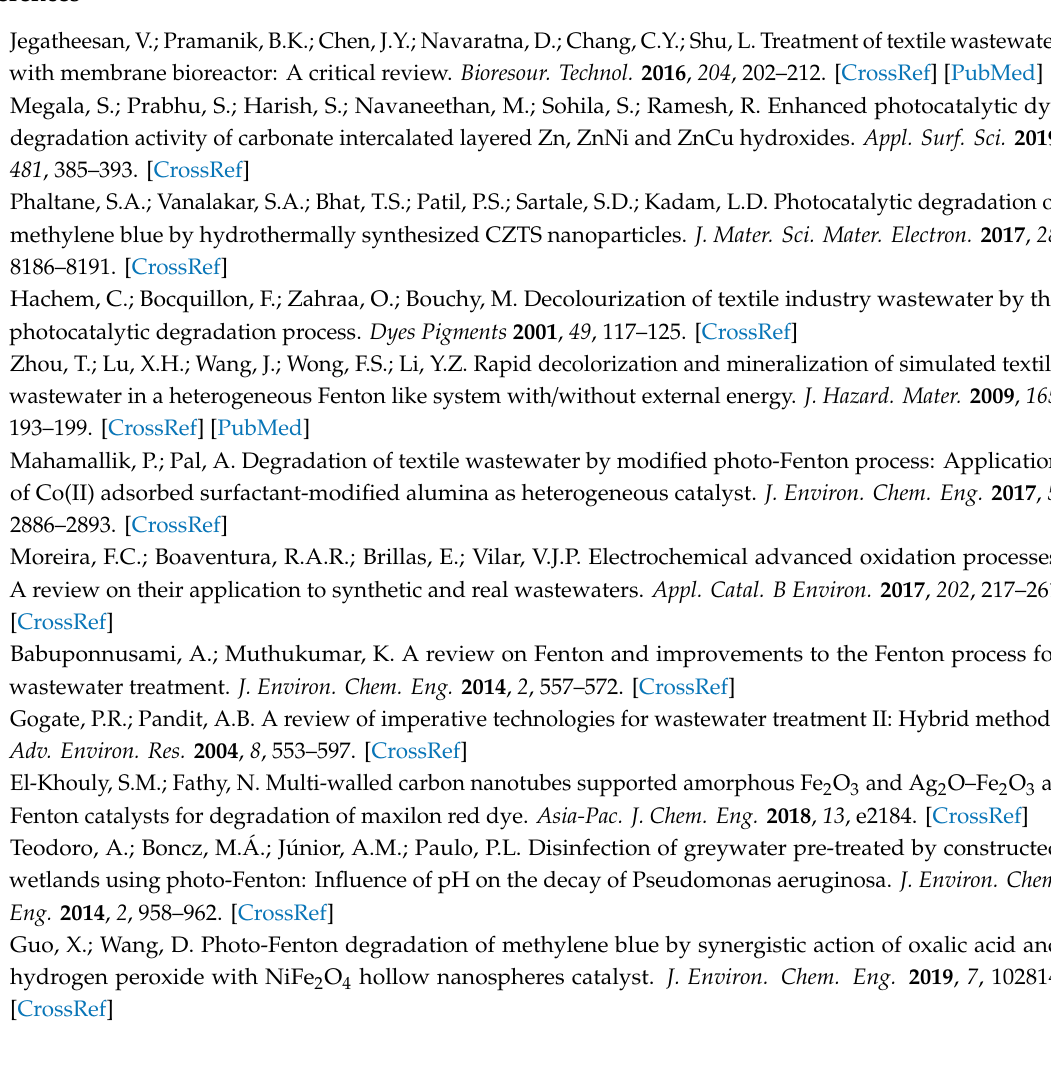
Figure S1: Powder XRD patterns for KFO-20 after four